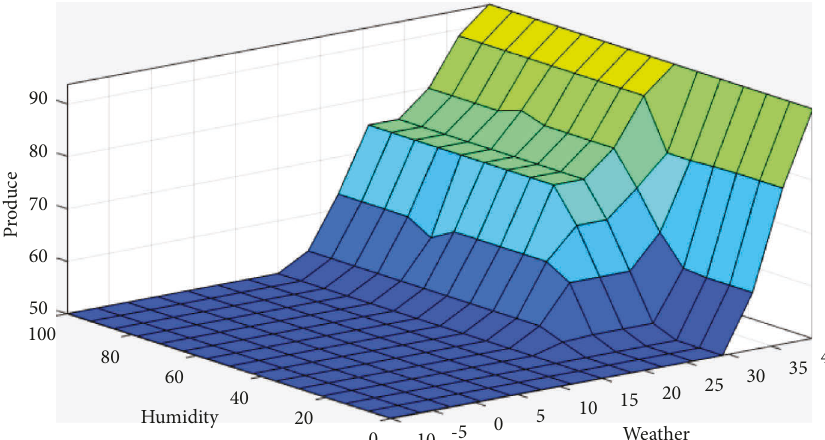
Figure 4: View of the level displayed by MATLAB software designed for